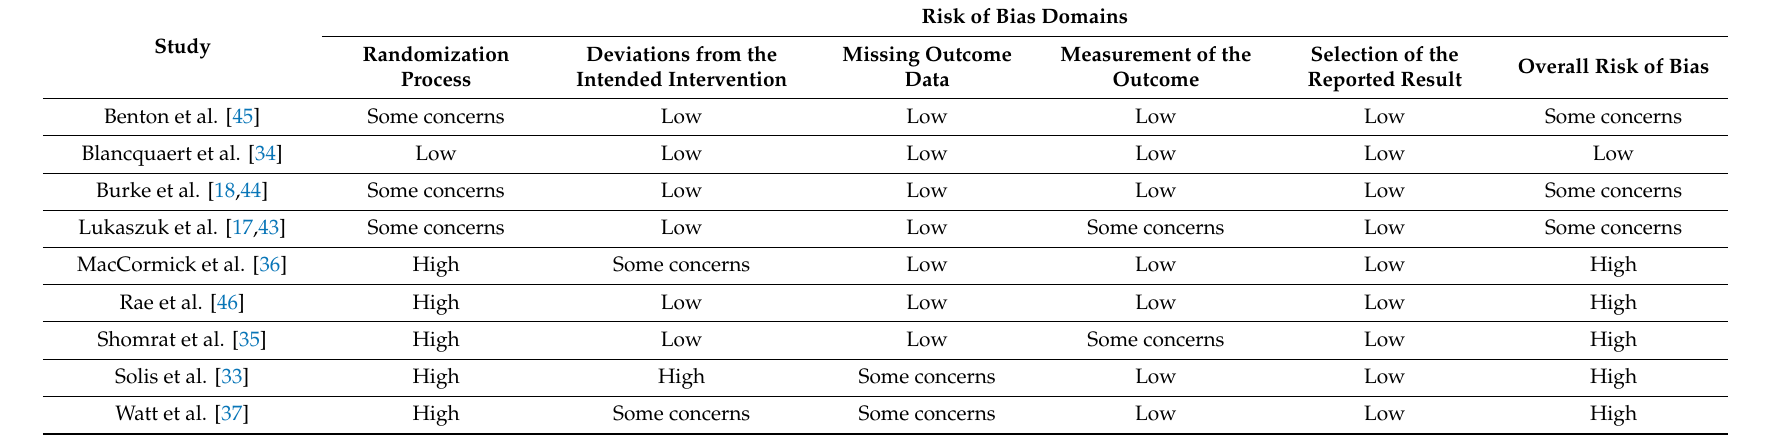
Table 2. Risk of bias in studies involving creatine supplementation in